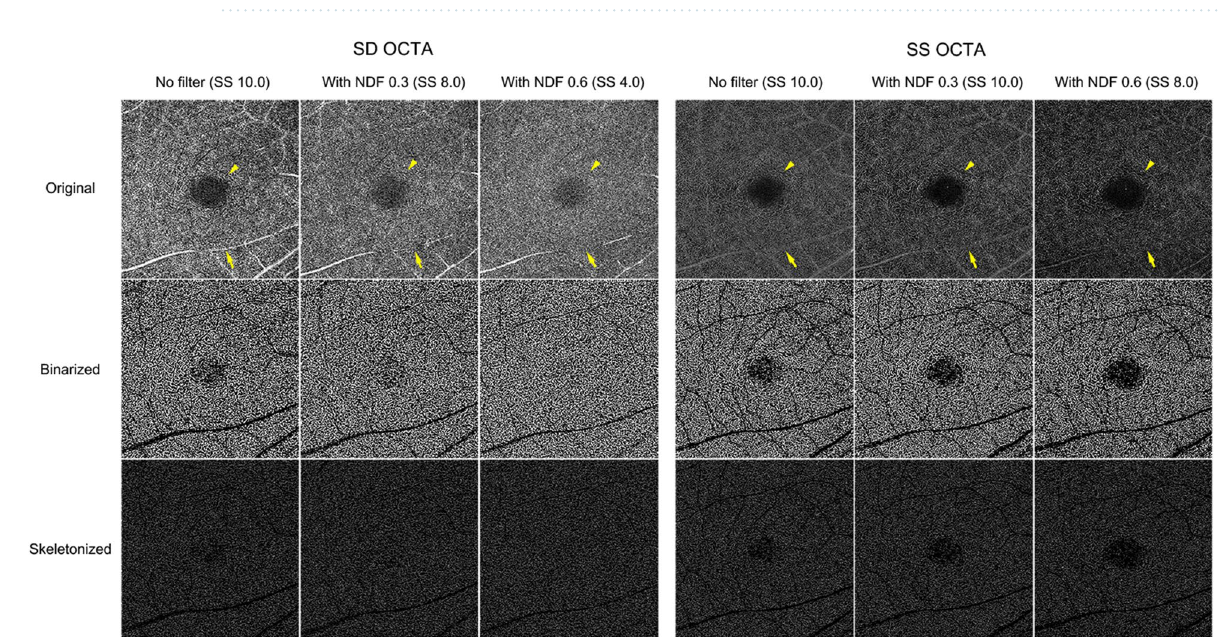
Figure 2. Representative 6 × 6 mm en face deep capillary plexus (DCP) optical coherence tomography angiography (OCTA) images with application of neutral density filter (NDF) of a 35-year-old healthy male subject. Signal strength (SS) decreased significantly for spectral domain OCTA (SD-OCTA) compared to swept- source OCTA (SS-OCTA). The boundaries of the fovea avascular zone became unclear (yellow arrowhead), and projection of overlying retinal vessels was faint (yellow arrow) when SS decreased. These features were more prominent for SD-OCTA than for SS-OCTA. For SD-OCTA, the vessel density (VD) was 39.3%, 37.8%, and 37.8%, and the vessel length density (VLD) was 11.1%, 10.8%, and 11.0% when SS decreased, respectively. For SS-OCTA, the VD was 33.7%, 34.1%, and 31.6%, and the VLD was 12.5%, 12.3%, and 11.4%,